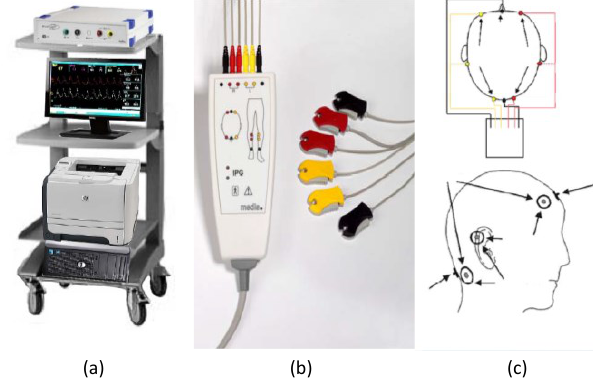
Fig.3: (a) REG monitoring device, (b) system of electrodes, (c) electrode attachment